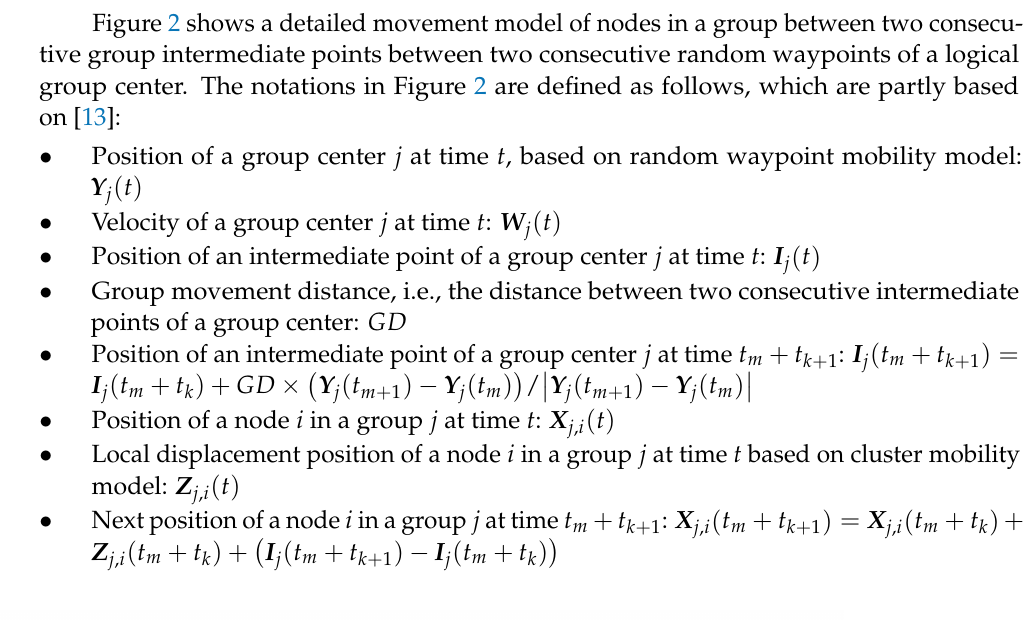
Figure 1. A considered group mobility model.